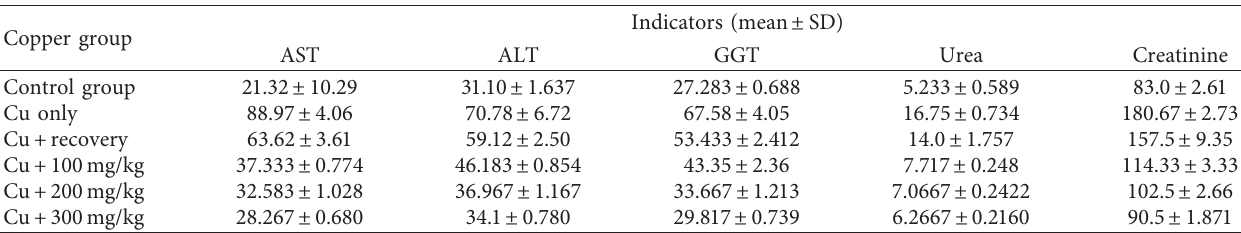
Table 4: Effects of EEVA on liver and kidney function biomarkers in rats with copper- (Cu-) induced heavy metal toxicity.